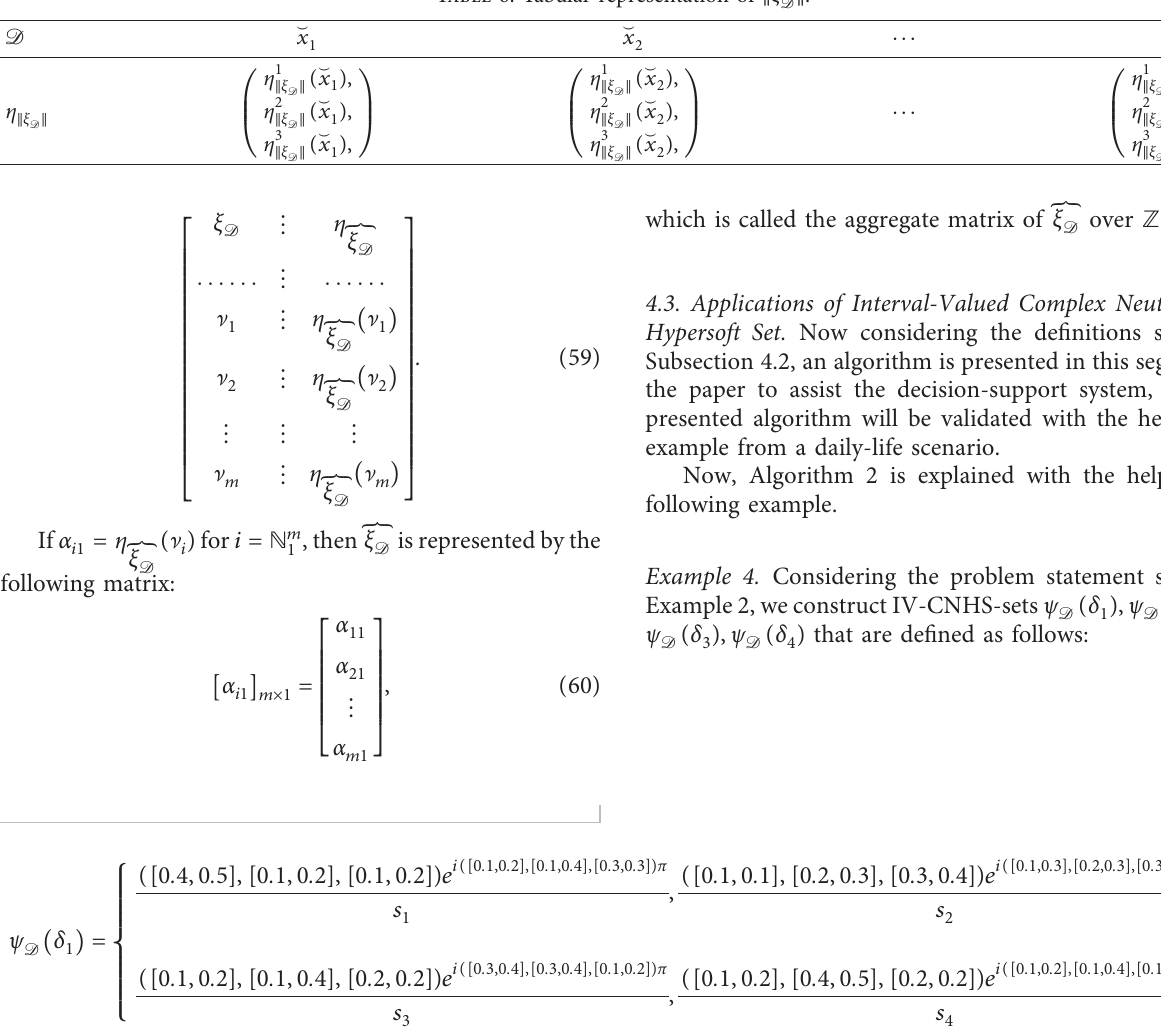
Table 6: Tabular representation of ‖ ξ